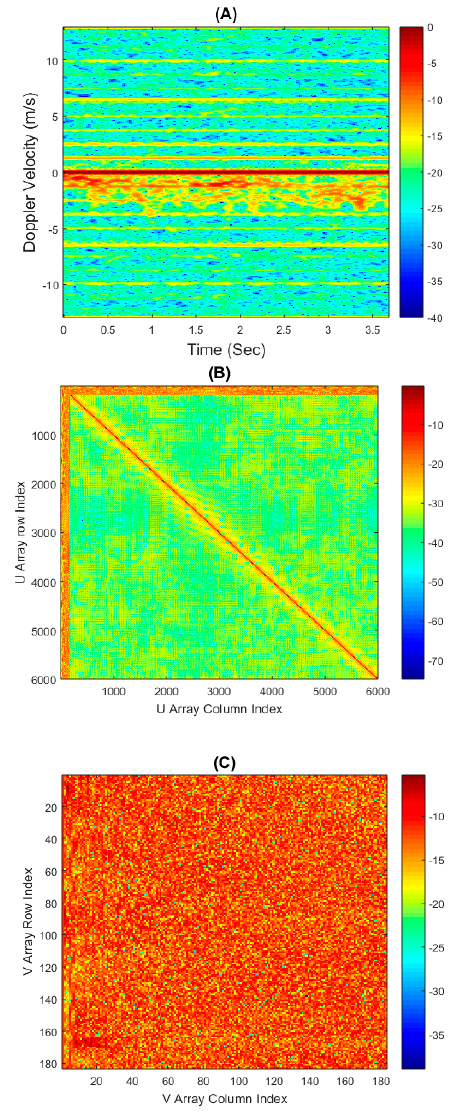
Figure 9. ( A ) micro-Doppler section from free handed motion; ( B ) Singular Value Decomposition (SVD) u Array plotted as 10 × log 10 ( u ) from micro-Doppler section; ( C ) SVD v Array plotted as 10 × log 10 ( v ) from micro-Doppler section.